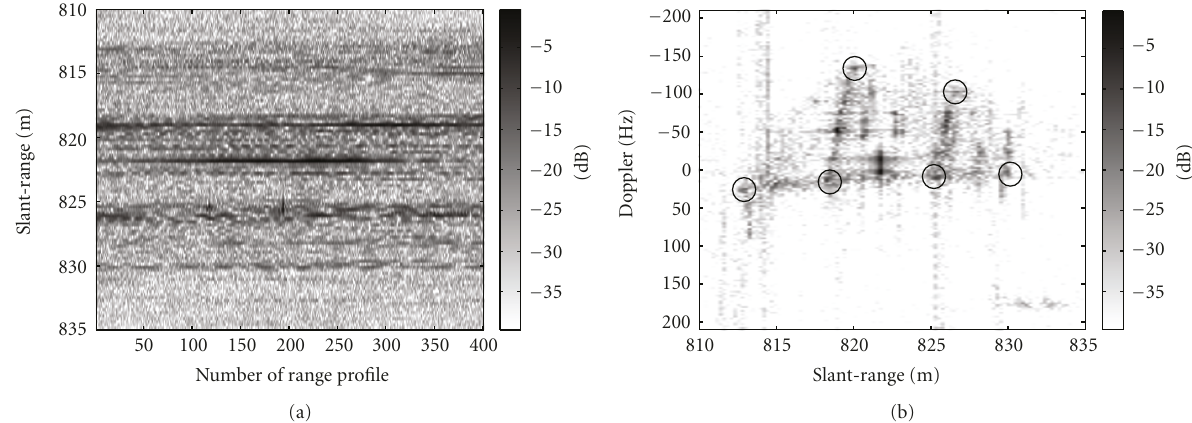
Figure 11: (a) Range profiles and (b) ISAR image for the real data of the two-mast sailboat after applying the proposed